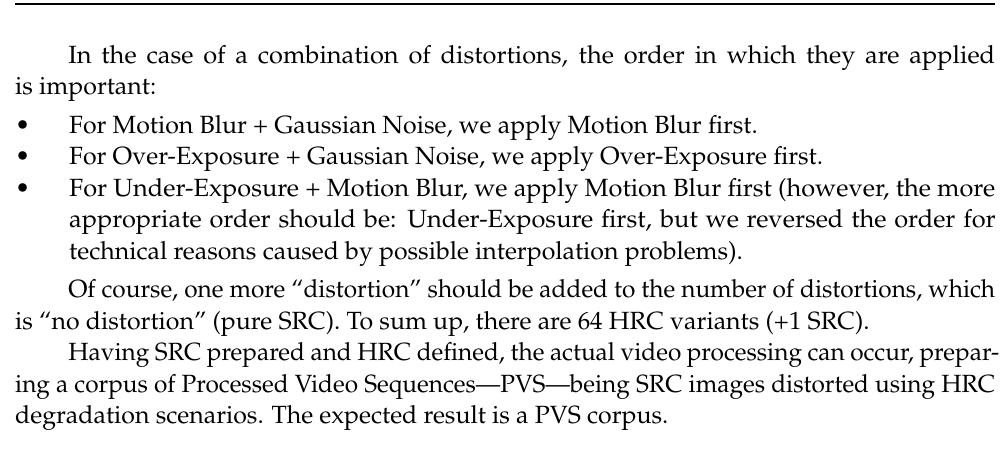
Table 2. Hypothetical Reference Circuits (HRC)—distortions. HRC #HRC Over/Under-Exposure (Photography) 12 Defocus (Blur) 6 Gaussian Noise 6 Motion Blur 6 JPEG 19 Motion Blur + Gaussian Noise 5 Over-Exposure + Gaussian Noise 5 Under-Exposure + Motion Blur PVS